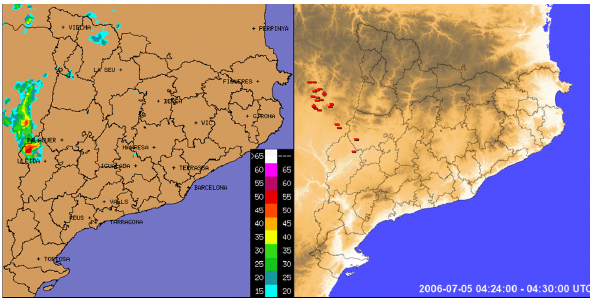
Fig. 2. Example of a 1-km a.s.l. radar reflectivity composite CAPPI product (left) and CG lightning observations (right), at 04:30UTC of 5 July